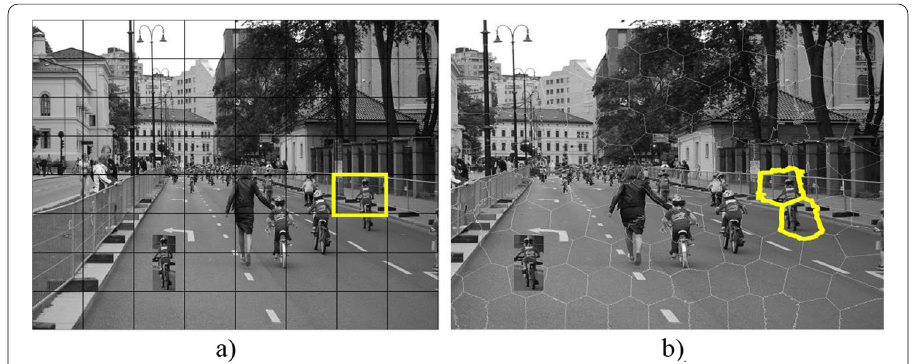
Fig. 2 Comparison of the segmentation effects of two different segmentation schemes. a Uniformly non‑overlapping segmentation, b SLIC